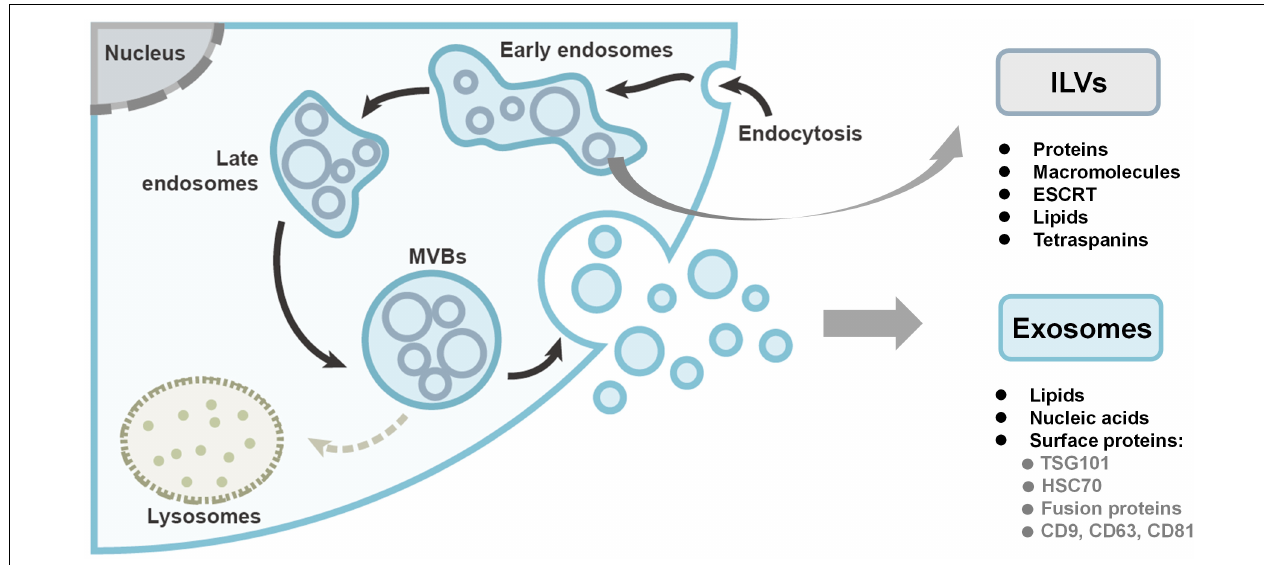
FIGURE 1 | The biogenesis and compositions of exosomes. Exosomes originate as intraluminal vesicles (ILVs) through the inward budding of the plasma membrane within early endosomes. Early endosomes are then matured into late endosomes and ultimately multivesicular bodies (MVBs). Finally, the MVBs either undergo degradation or fuse with the plasma membrane to secrete the ILVs as exosomes. Figure redrawn from Kalluri and LeBleu (2020).